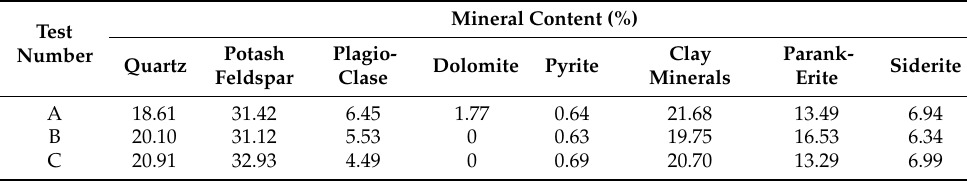
Figure 1. Photograph of shale outcrop ( a ) and schematic of the wellbore sealing ( b ). Table 1. Shale mineral composition measured by